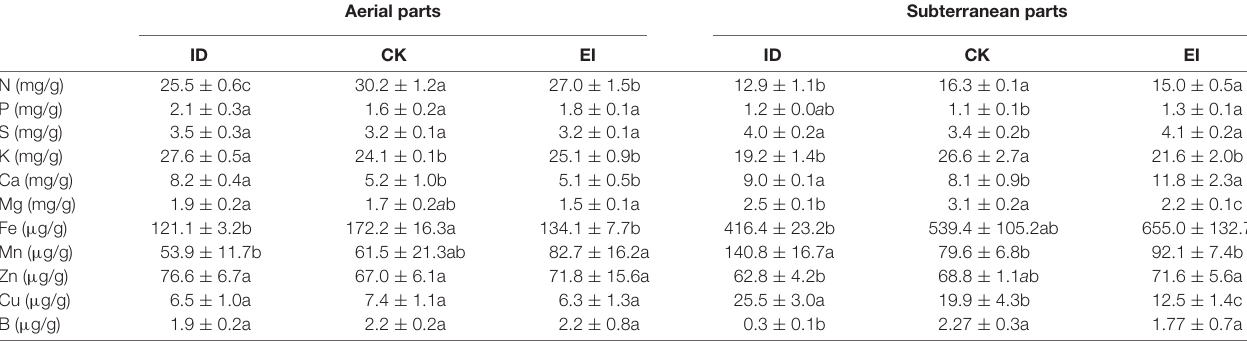
TABLE 1 | Nutrient concentration of aerial parts and subterranean parts in A. catechu under different treatments. Aerial